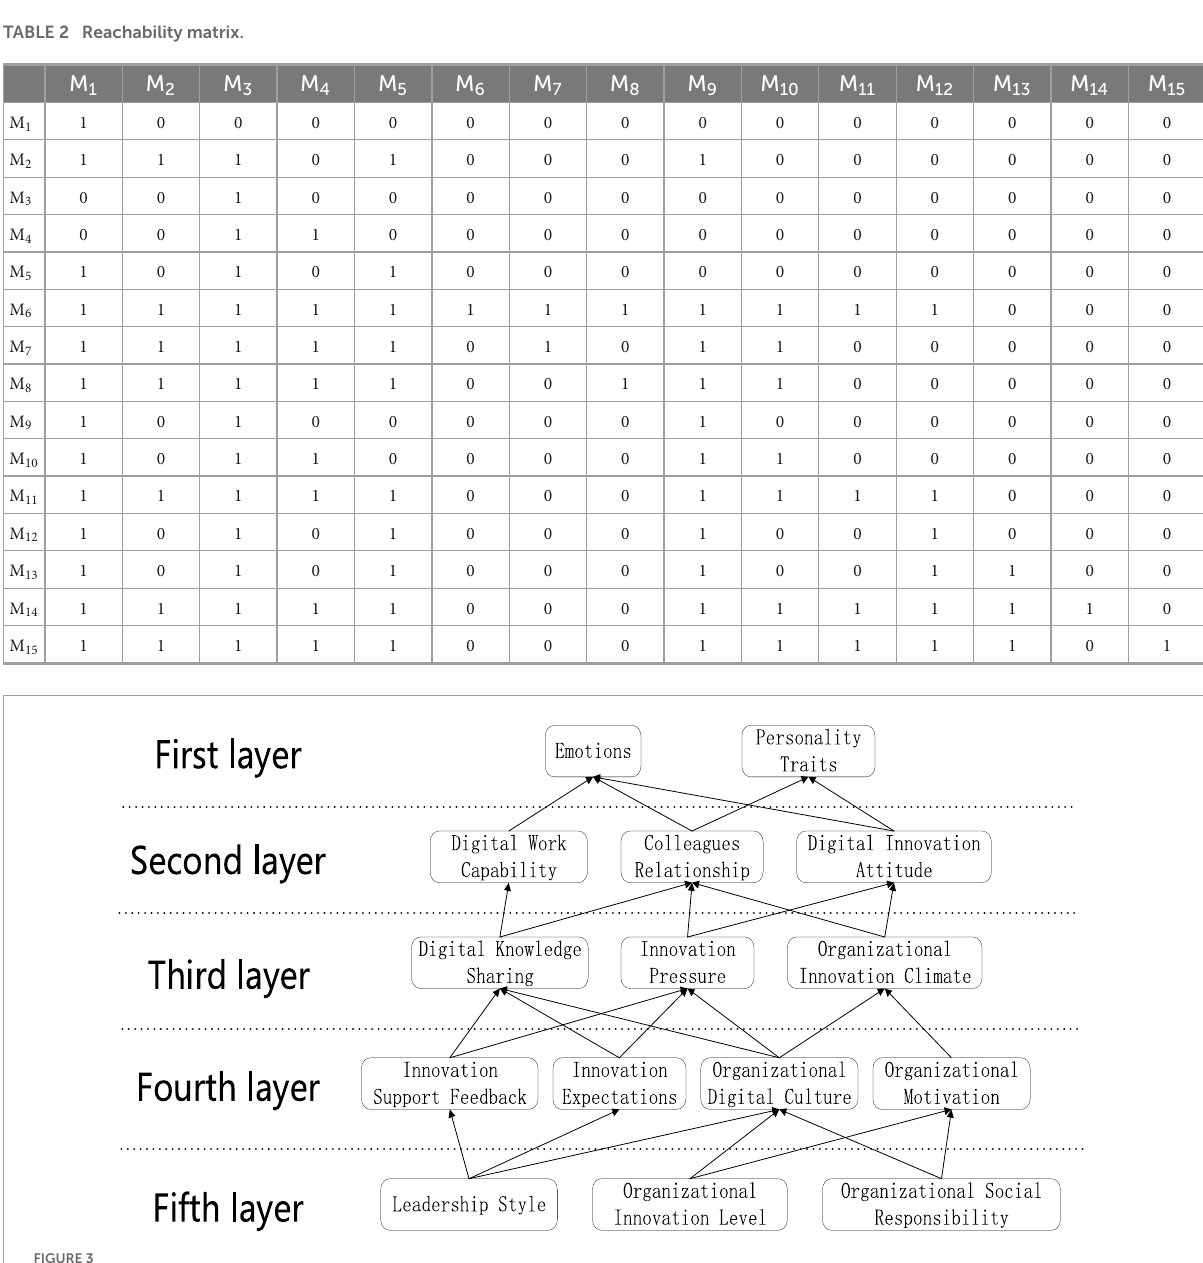
FIGURE3 Recursive structural relationship model of factors influencing employees’ innovation